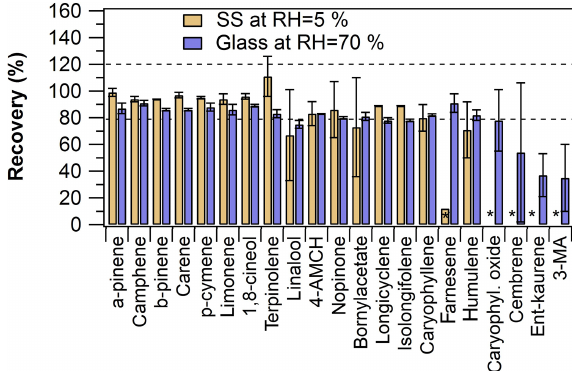
Figure 4. Comparison of online sampling mode recoveries obtained by using either the empty stainless-steel (SS) tube (at RH = 5%) or the empty glass tube (at RH = 70%) in online sampling. The empty spaces marked with an asterisk indicate <LOQ results in on- line sampling. The error bars represent repeatability ( n =